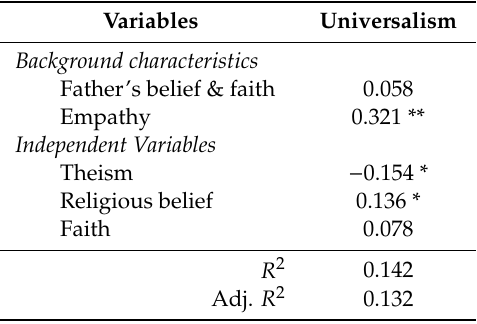
Table 6. Regression analysis for universalism with weights ( β ) for each variable and total explained variance ( R 2 and adjusted R 2